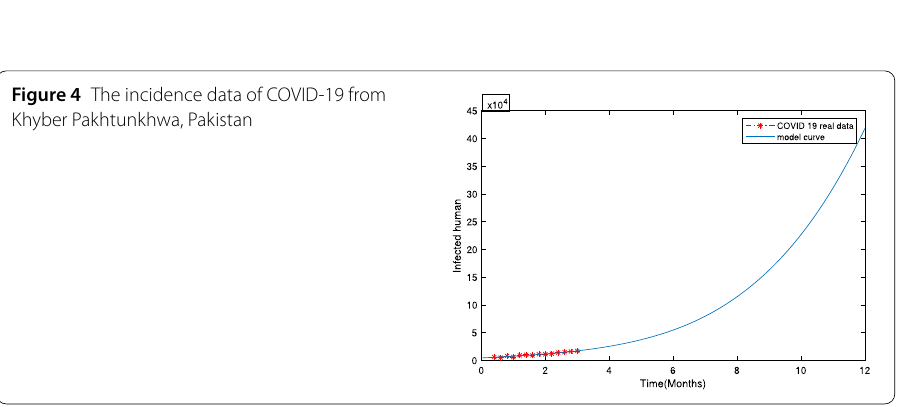
Figure 4 The incidence data of COVID-19 from Khyber Pakhtunkhwa, Pakistan